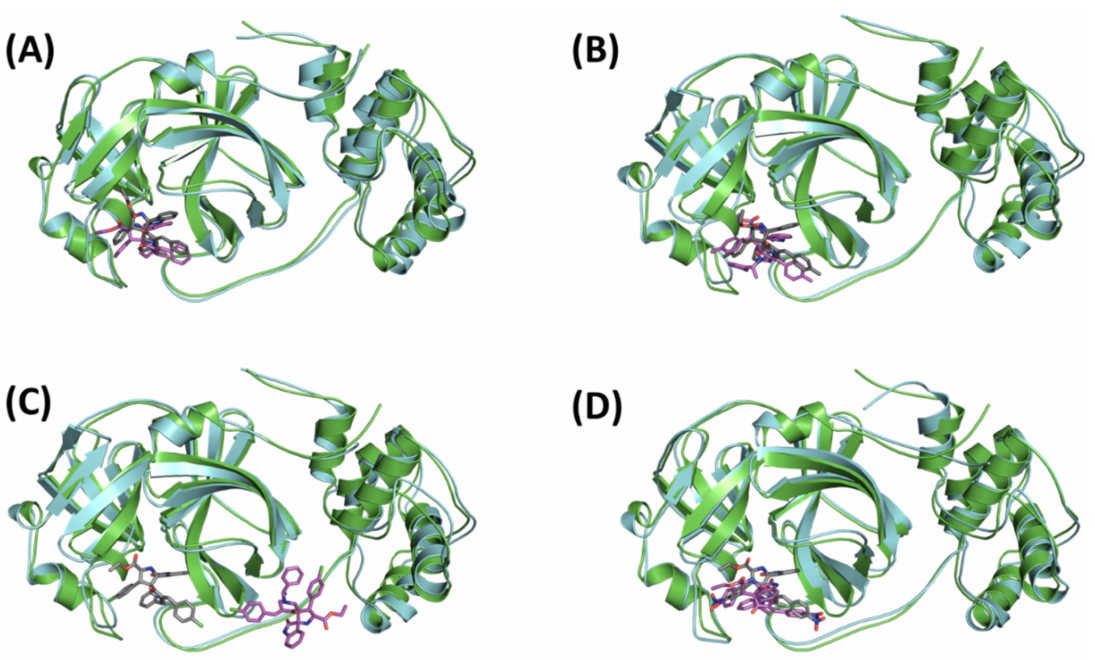
Figure 7. Overlay of the crystal structure (light cyano) and a representative MD structure (green cartoon) of SARS-CoV-M pro bound to the docked pose of ( A ) compound 4a ( B ) compound 4b ( C ) compound 4d and ( D ) compound 4e . For each ligand, the initial docked ligand is presented as grey sticks, while that of the representative MD structure is presented as magenta sticks.